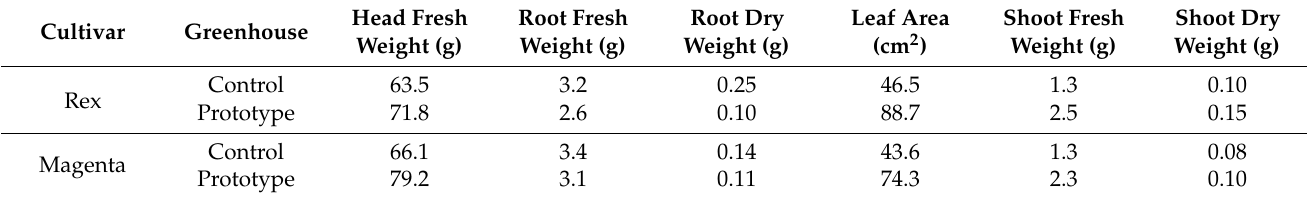
Table 3. Lettuce fresh and dry weight and leaf area comparison.